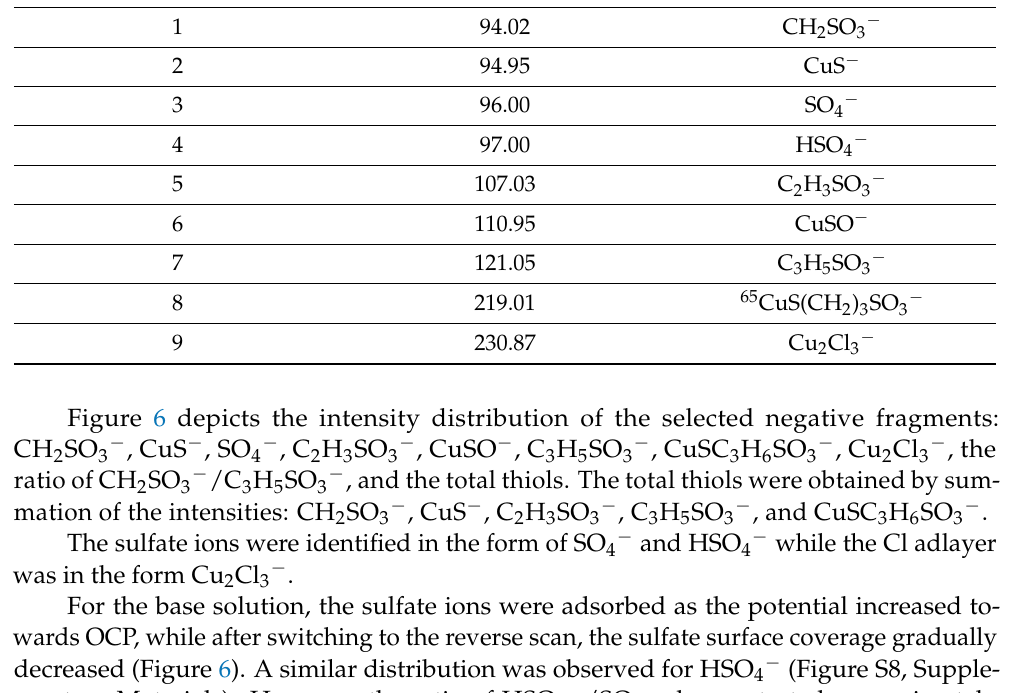
Table 2. The assignment of the most distinct negative fragments identified in the TOF-SIMS mass spectra. No. Centre Mass (u)